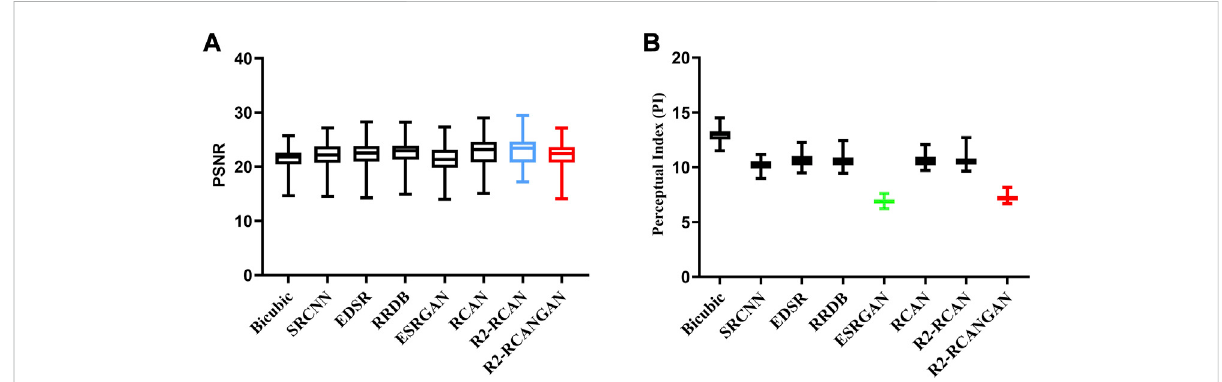
FIGURE 5 BoxplotofPSNRandPIonthetestset.TheR2-RCANGAN(red)hasgoodreconstructionaccuracyandperceptualquality.IntermsofPSNR,R2- RCAN(blue)isthebest,butithasapoorPIperformance.IntermsofPI,ESRGAN(green)isthebest,butitsPSNRistoolow. (A) PSNRonthetestset, (B) PI on the test set.